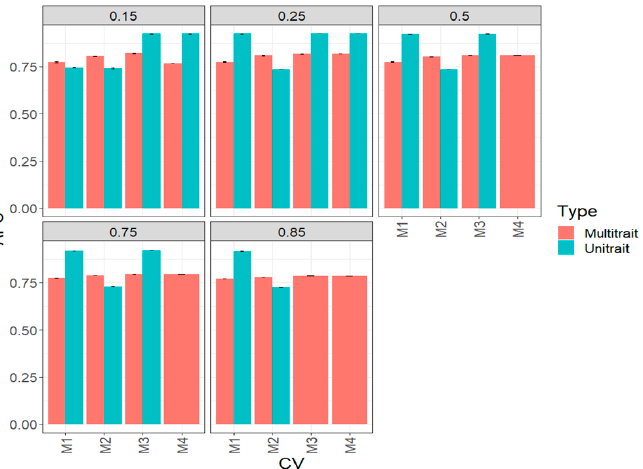
Figure 4. Prediction performance for the complete (big) wheat data set in terms of average Pearson’s correlation (APC) of the four methods of sparse testing (M1, M2, M3 and M4) under unit-trait and multi-trait models for 5 percentages of testing: 15% (0.1), 25% (0.25), 50% (0.5), 75% (0.75) and 85% (0.85).